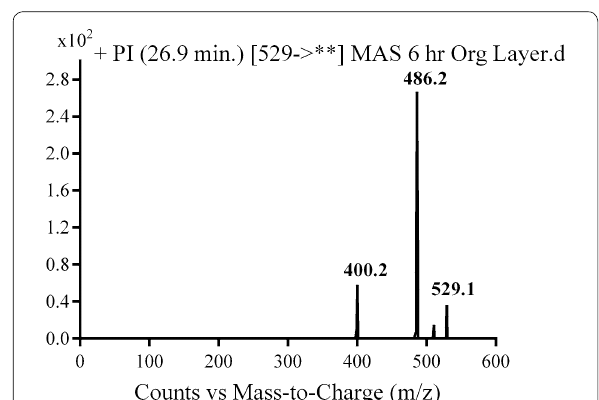
Fig. 8 PI mass spectrum of parent ion (M6) at m/z